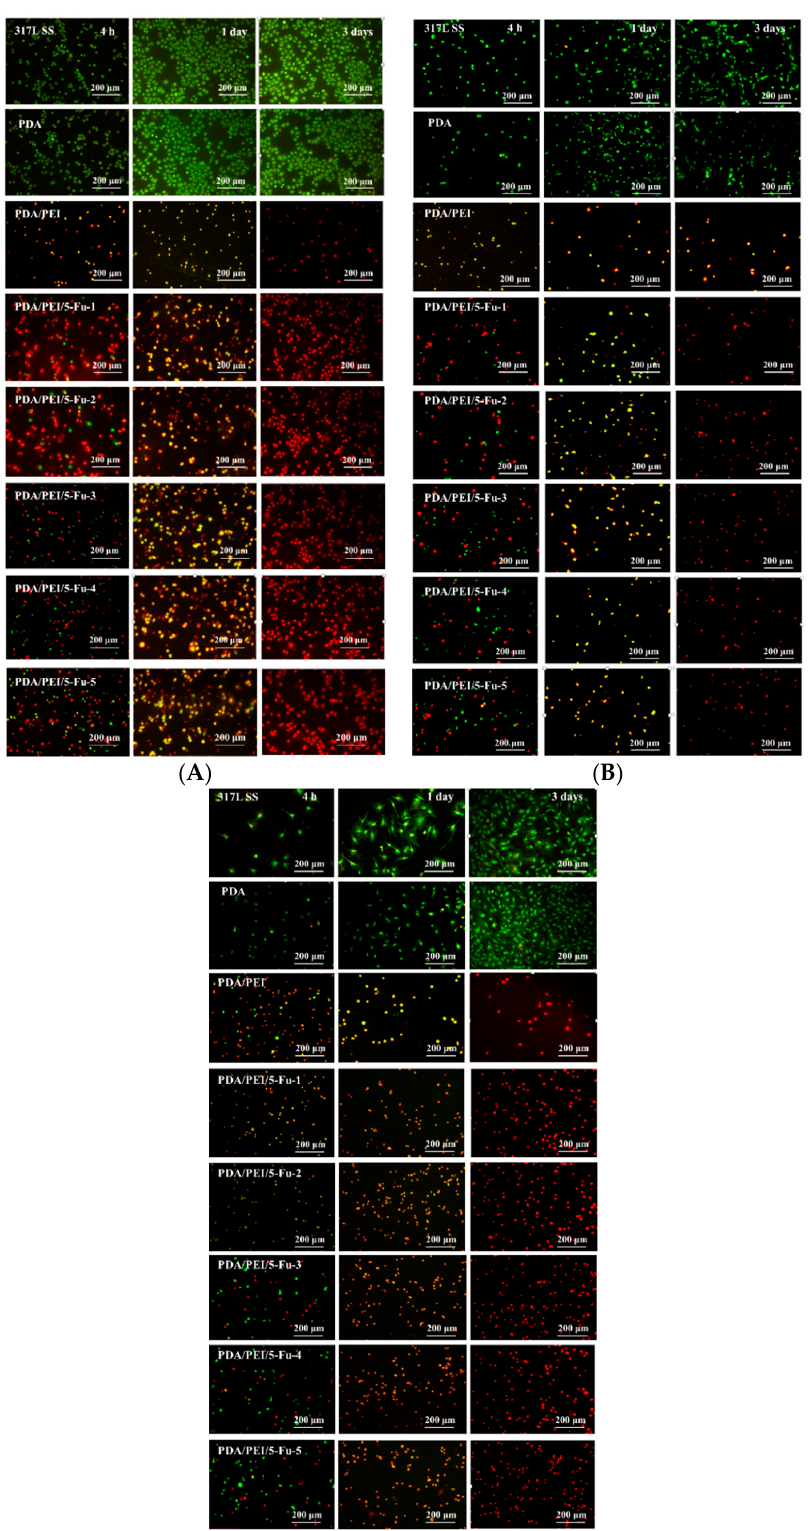
Figure 8. ( A ) Eca109, ( B ) Het-1A and ( C ) L929 cells apoptosis and necrosis on the PDA/PEI/5-Fu layers and reference surfaces (green intact nucleus: vital cells; dense green areas of chromatin condensation in the nucleus: early apoptosis; dense orange areas of chromatin condensation: late apoptosis; orange intact nucleus: secondary necrosis).